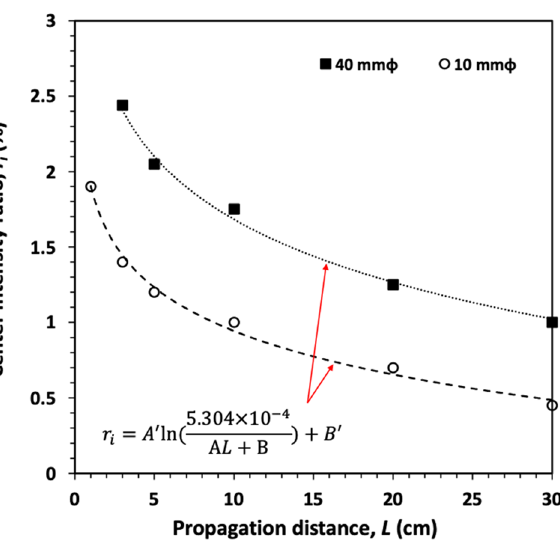
Figure 7. ( a ) Variation of the maximum center intensity ratio ( r i ) and relative propagation distance observed from the annular beam with diameters 40 mm (black squares) and 10 mm (open circles) in different cell lengths (1–30